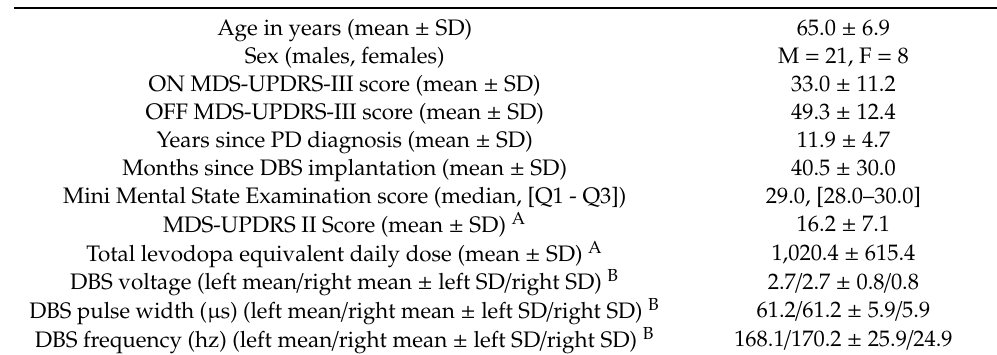
Table 1. Participant